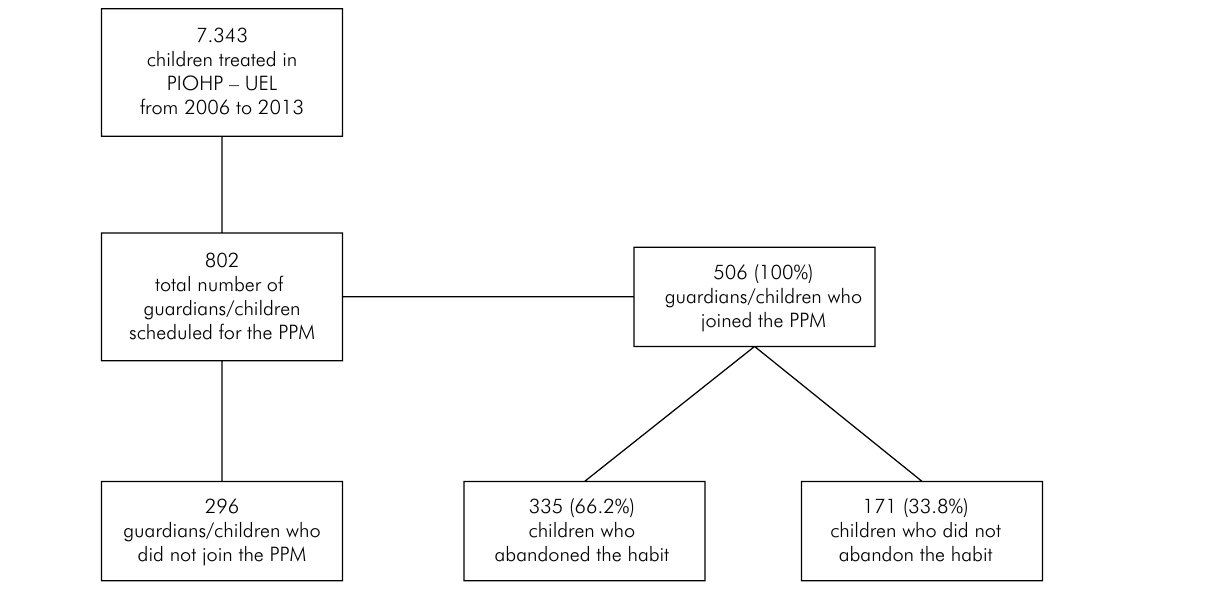
Figure. Organization